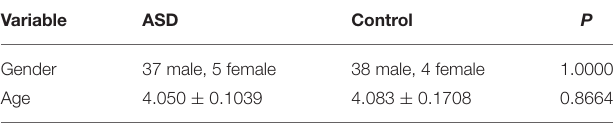
TABLE 1 | Demographic and clinical variables (Means and Standard Deviations).